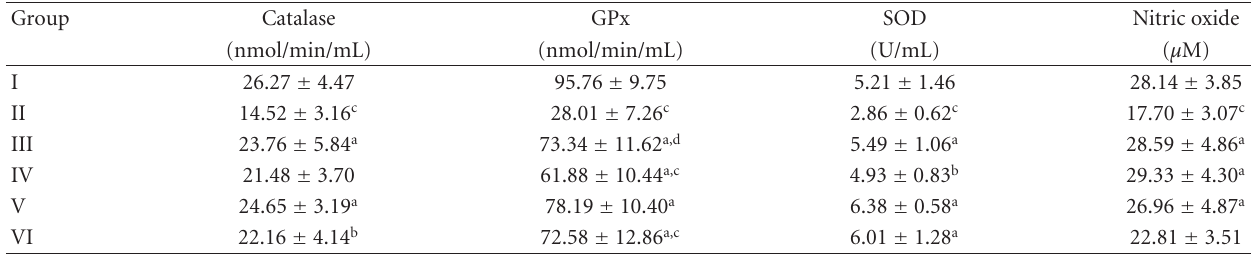
Table 4: E ff ect of supplementation on antioxidant enzymes and nitric oxide.